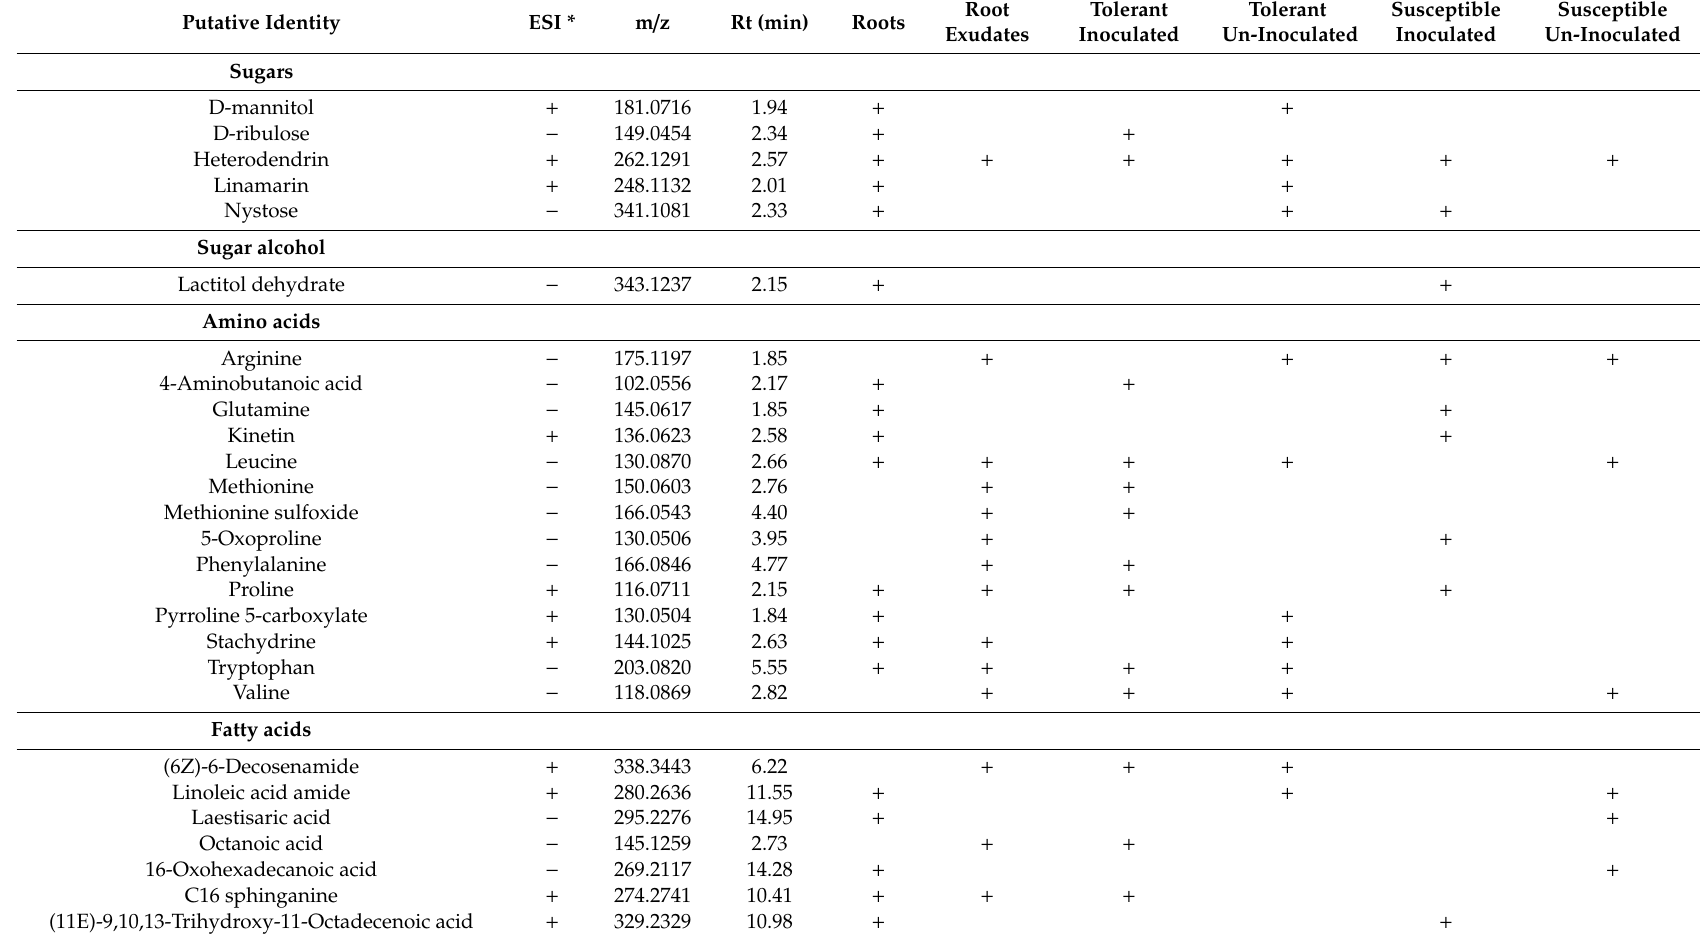
Table 2. Metabolites putatively identified in roots and root exudates from potato cultivars di ff ering in susceptibility to Spongospora subterranea f. sp. subterranea detected using